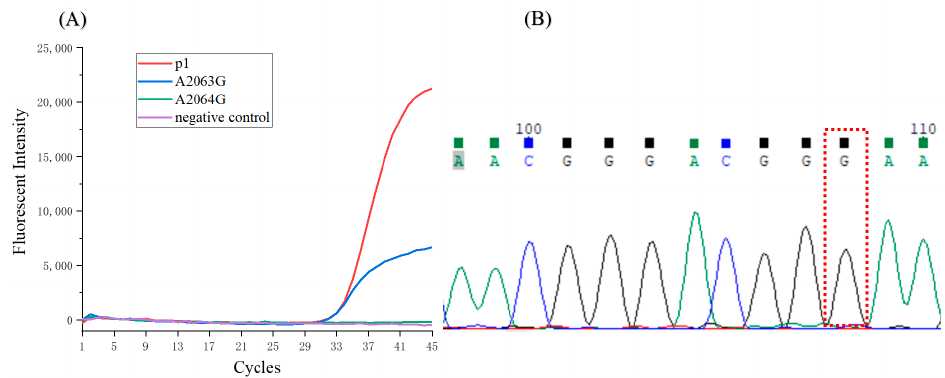
Figure 7. ( A )The qPCR curves of the clinical sample. ( B ) The sequencing result of the clinical sample.